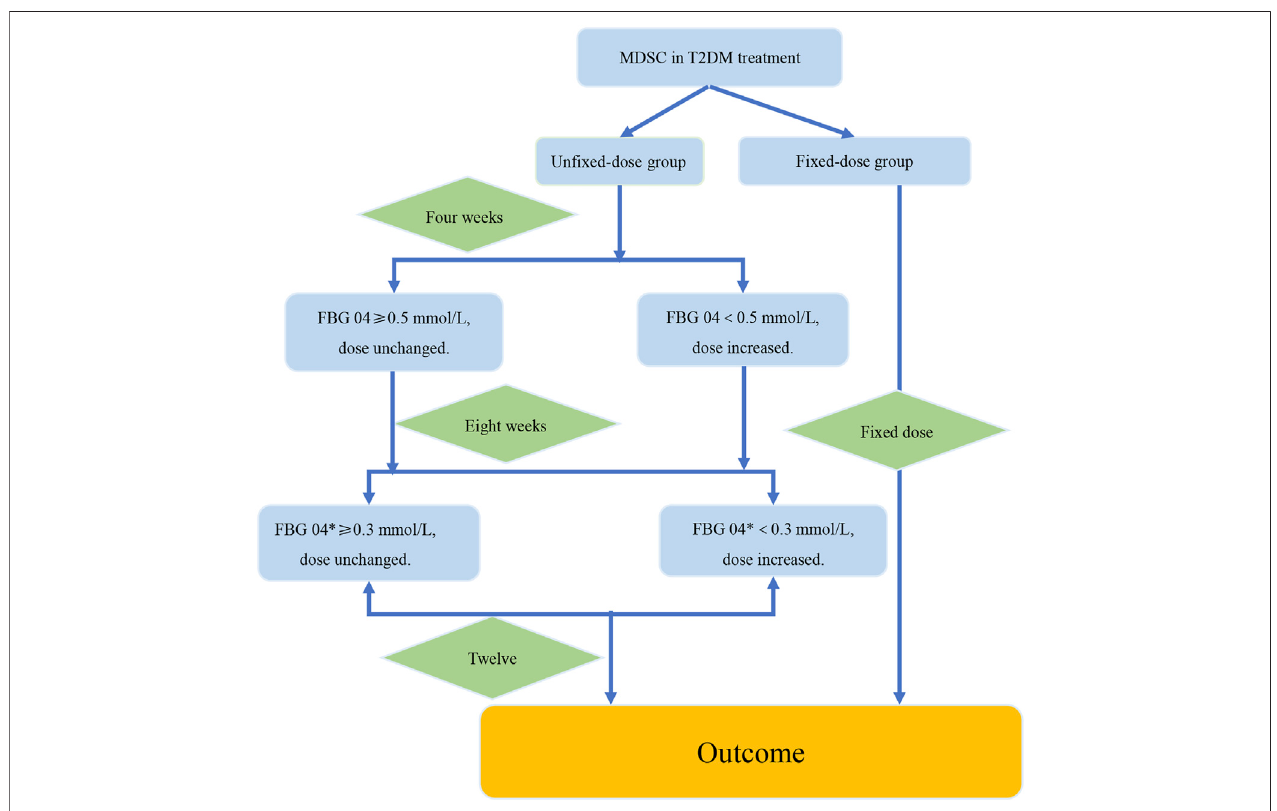
FIGURE 6 | The veri fi cation procedure diagram of the strategy of dosage modi fi cation. The difference value between the week 4 and the week 8 was recorded as FBG04*.FBG04 ≥ 0.5 mmol/Lobtainedfromanalysisofstudy1.FBG04* ≥ 0.3 mmol/Lobtainedfromanalysisofthehigh-dosegroupinstudy2.Theinterventiongroup and the control group were the fi xed-dose group and the un fi xed-dose group respectively, and the initial dose was the same in both groups. In addition, the dose was fi xedat12 weeksinthe fi xed-dosegroup.Intheun fi xed-dosegroup,wecontinuedtheinitialdoseatweek4whenthedecreasingrangeofFBGlevelatweek4from baseline (FBG 04*) was greater than 0.5 mmol/L and increased the dose at week 4 when the decreasing range of FBG level at week 4 from baseline was less than 0.5 mmol/L.Forweek8,increasedthedoseatweek8ifthedecreasingrangeofFBGlevelatweek8fromweek4waslessthan0.3 mmol/L.IfthedecreaseofFBGlevel was more than 0.3 mmol/L at the week 8 from the week 4, then it would indicate that the dose was large enough and dose unchanged. Finally, the outcomes were analyzed at week 12.